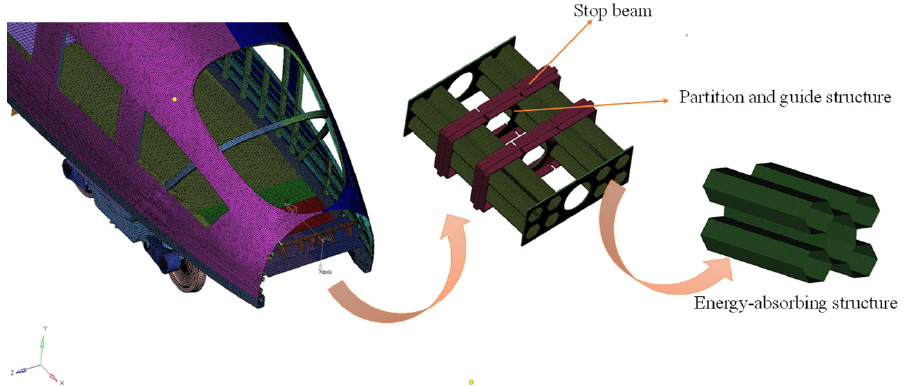
Figure 1. Multi-cell structure of the high-speed train.